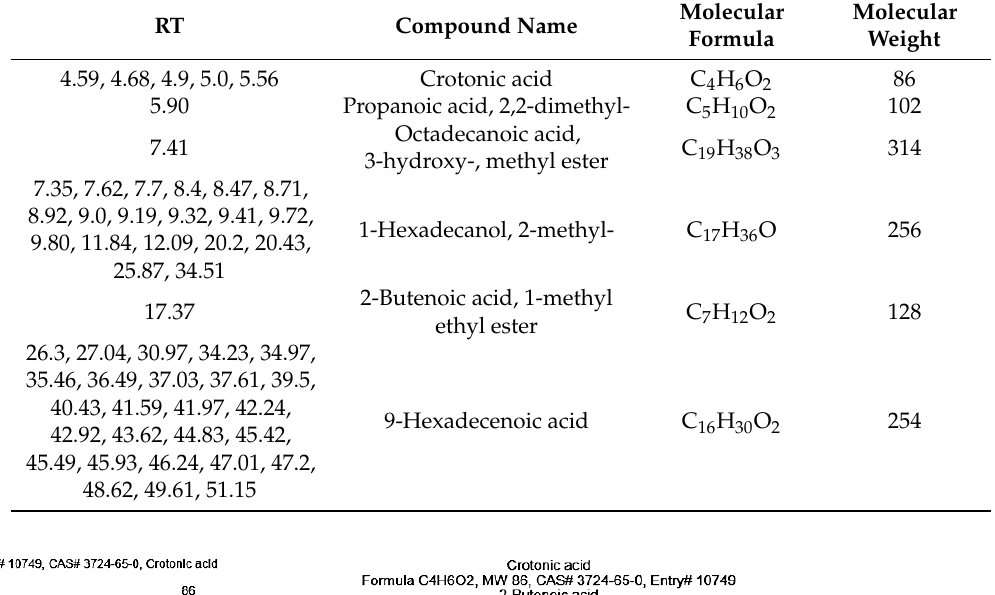
Table 3. GC-MS data table for polyhydroxybutyrate (PHB).